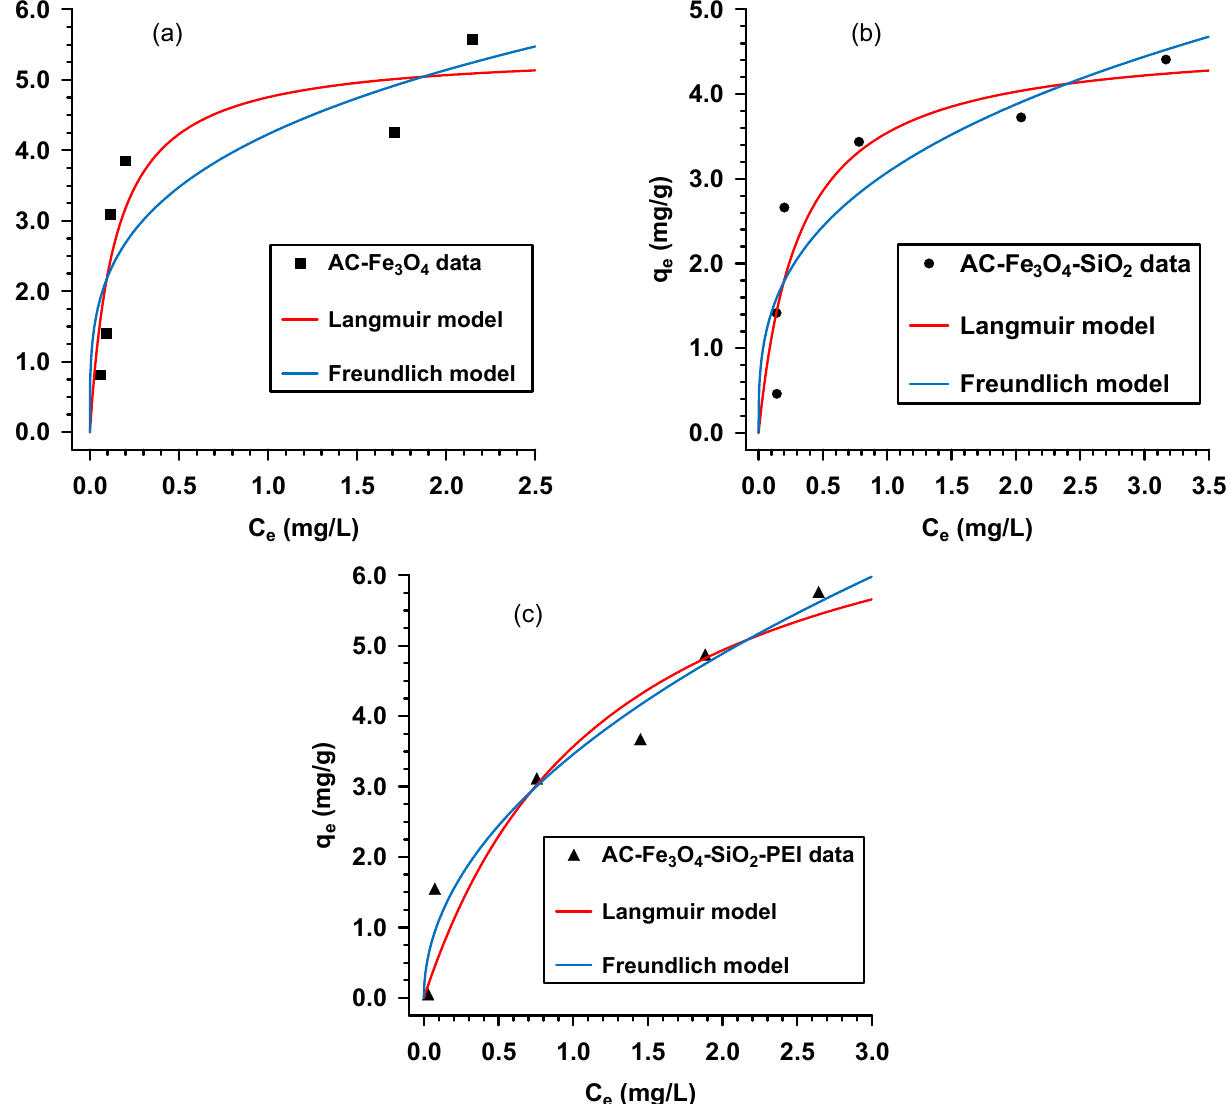
Figure 9. Isotherm modeling for the adsorption of Cr(VI) by AC-Fe 3 O 4 ( a ), AC-Fe 3 O 4 -SiO 2 ( b ), and AC-Fe 3 O 4 -SiO 2 -PEI ( c ) at 45 °C. Table 2. The Freundlich and Langmuir adsorption isotherm parameters at 45 °C.